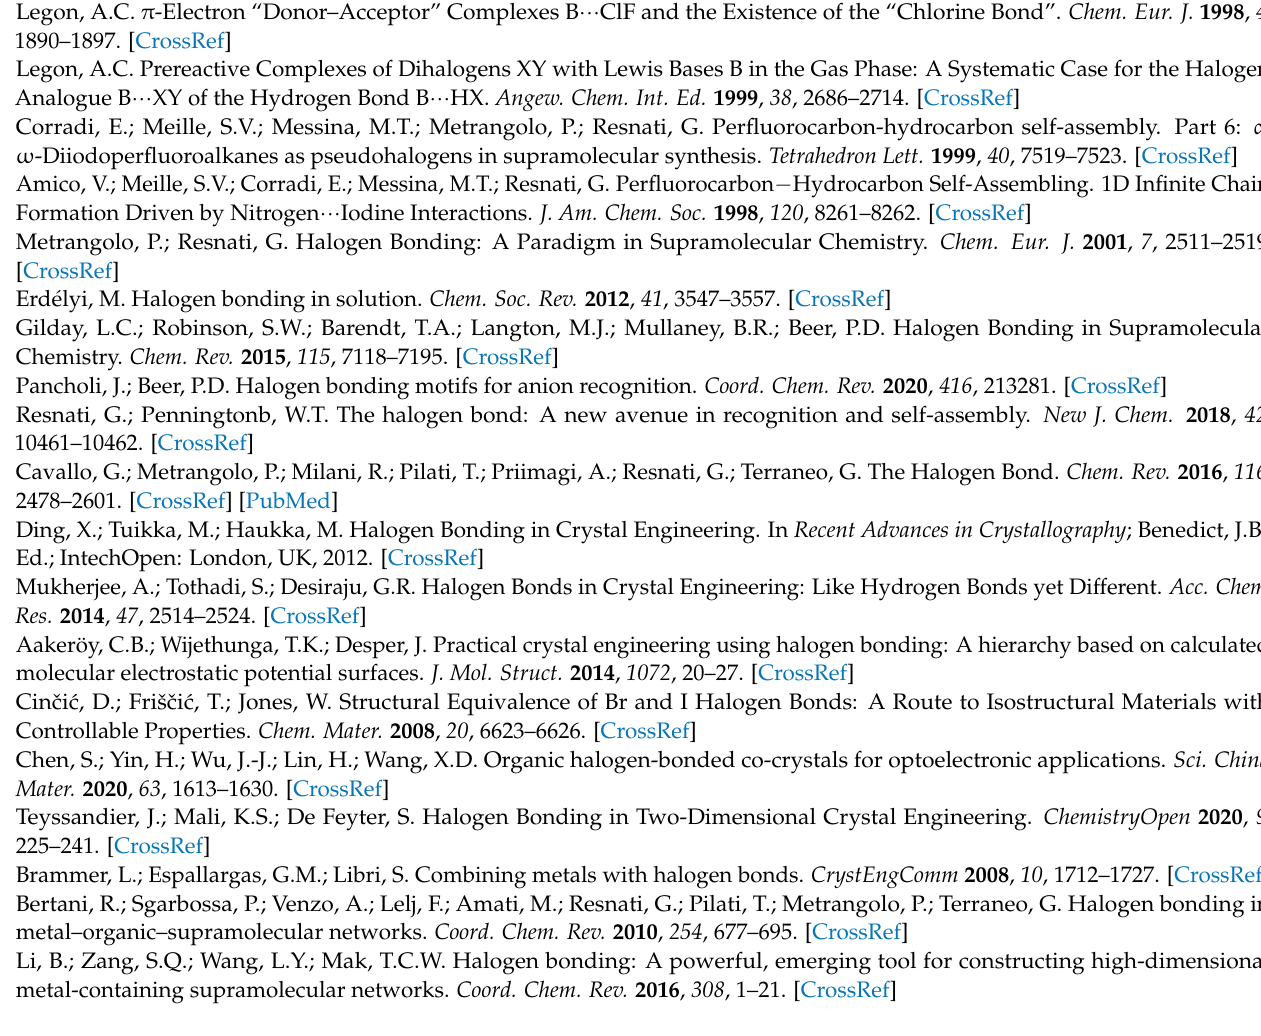
PXRD patterns of ( otol )( 135tfib ) 2 ; Figure S11. DSC thermogram of product of solution synthesis of ( pphda )( 14tfib ); Figure S12. DSC thermogram of product of solution synthesis of ( bnzd )( 13tfib )2; Figure S13. DSC thermogram of product of solution synthesis of ( bnzd )( 135tfib ) 4 ; Figure S14. DSC thermogram of product of solution synthesis of ( otol )( 14tfib ); Figure S15. DSC thermogram of ( otol )( 135tfib ) 2 ; Table S1. Masses of reactants and volumes of solvents for successful crystallization experiments; Table S2. An overview and crystallographic data of the prepared compounds; Total elec- tron energies and Cartesian coordinates for optimised structures; An overview and crystallographic data of the prepared compounds. CCDC 2077218–2077222 contain crystallographic data for this paper. These data can be obtained free of charge from the Director, CCDC, 12 Union Road, Cambridge,